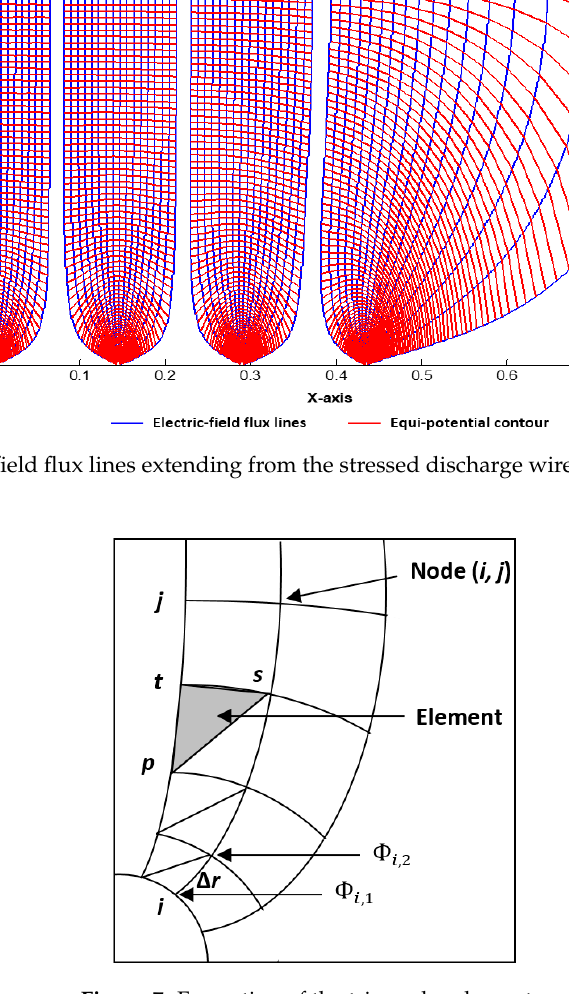
Figure 7. Formation of the triangular elements.